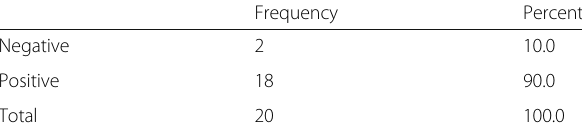
Table 1 Preoperative wire localization number and